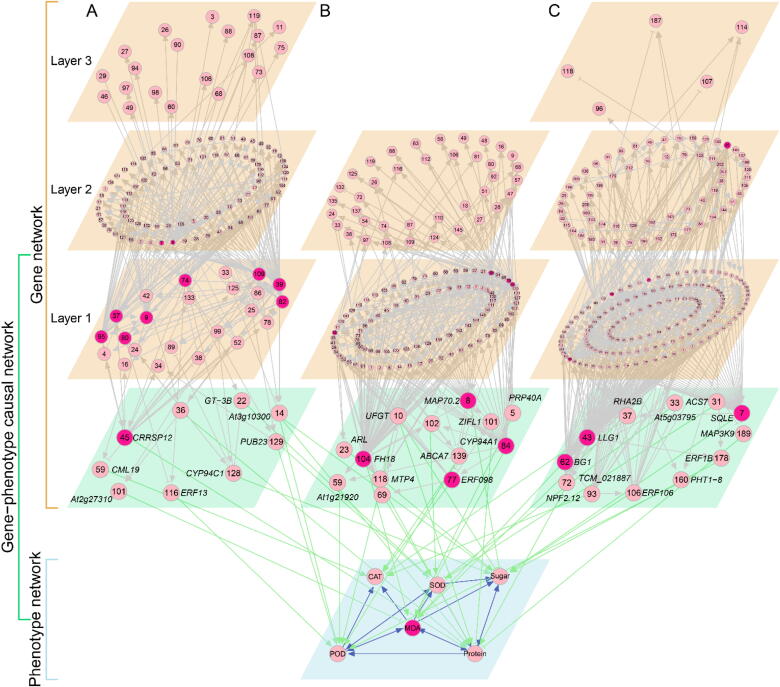
The regulatory networks among 136, 144 and 219 genes from modules 4 (A), 9 (B) and 10 (C), respectively, and their links to the phenotypic network of six physiological traits through causal networks. Hub genes within each module are named transcriptional factors that may be related to salt-resistant processes. Arrowed line denotes activation and T-shaped line indicates inhibition. The thickness of the lines stands for the strength of gene interaction. Some pairs of genes, like 4 and 9, are mutually regulated.